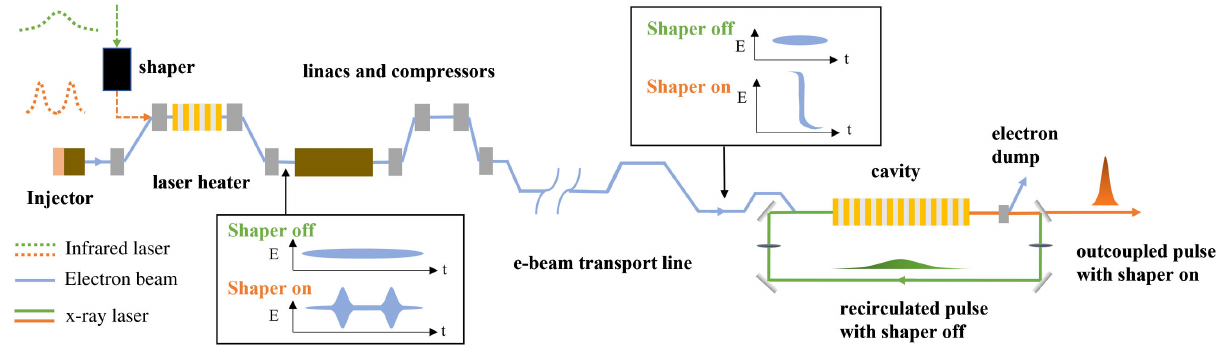
FIG. 1. Setup of electron beam shaping and radiation outcoupling from XRAFEL: laser heater, linacs and bunch compressor chicanes, long transport line, and cavity wrapped undulator